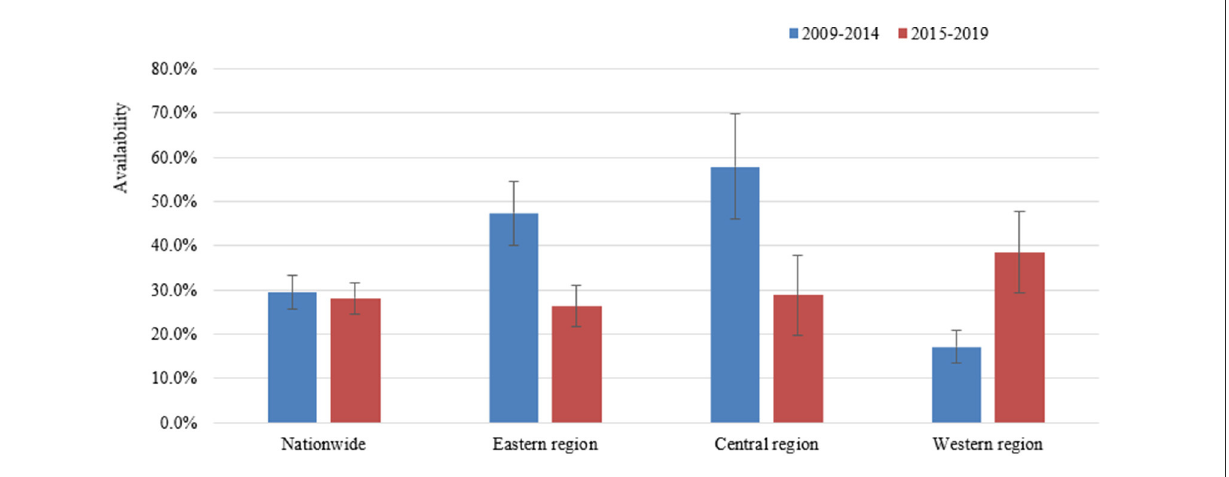
FIGURE2 The availability of essential medicines in